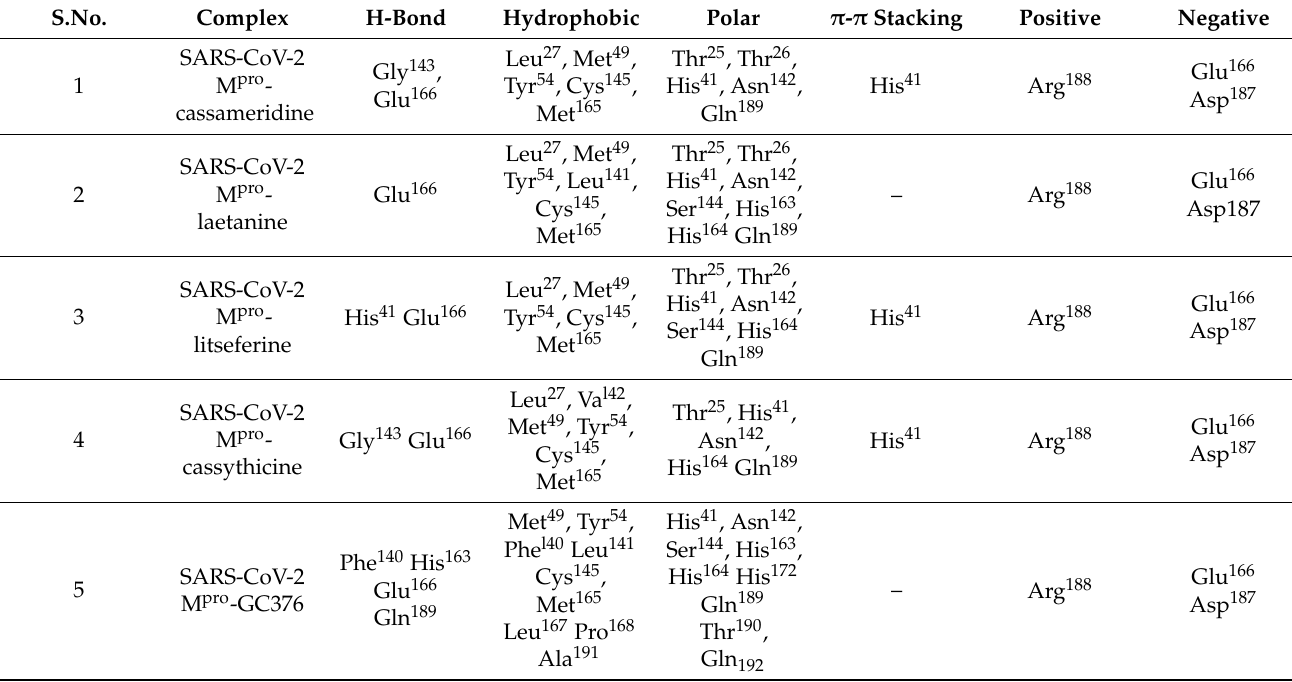
Table 2. Intermolecular interaction patterns for the phytochemical compounds docked in the SARS- CoV-2 M pro protein binding pocket in conformation with the active